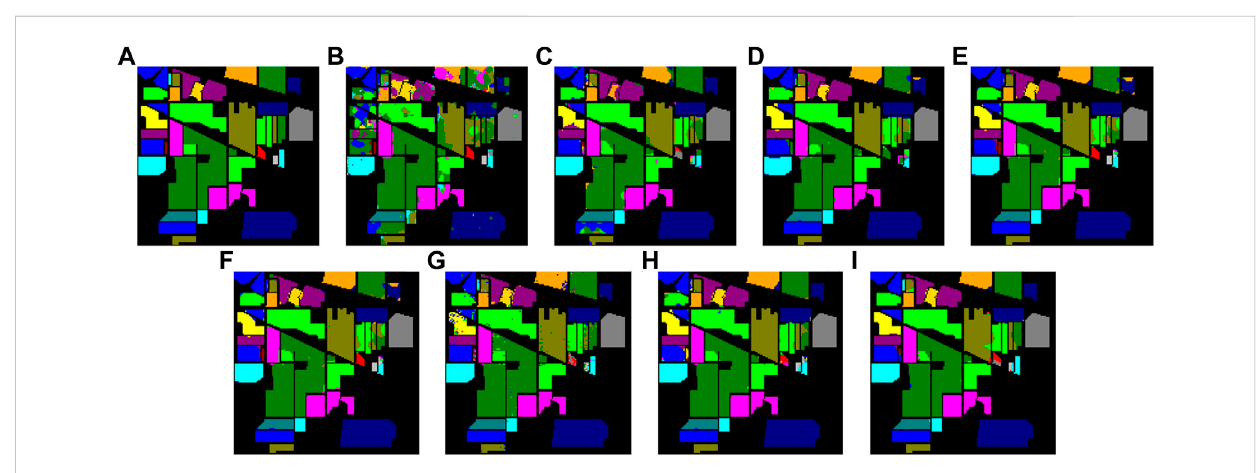
FIGURE 3 Classi fi cation results of the Indian pines dataset. (A) Ground-truth map, (B) EMP-SVM, (C) SSRN, (D) ResNet, (E) PyResNet, (F) CNAS, (G) MLP-Mixer, (H) ANAS-CPA-LS, and (I) (I) CK- β